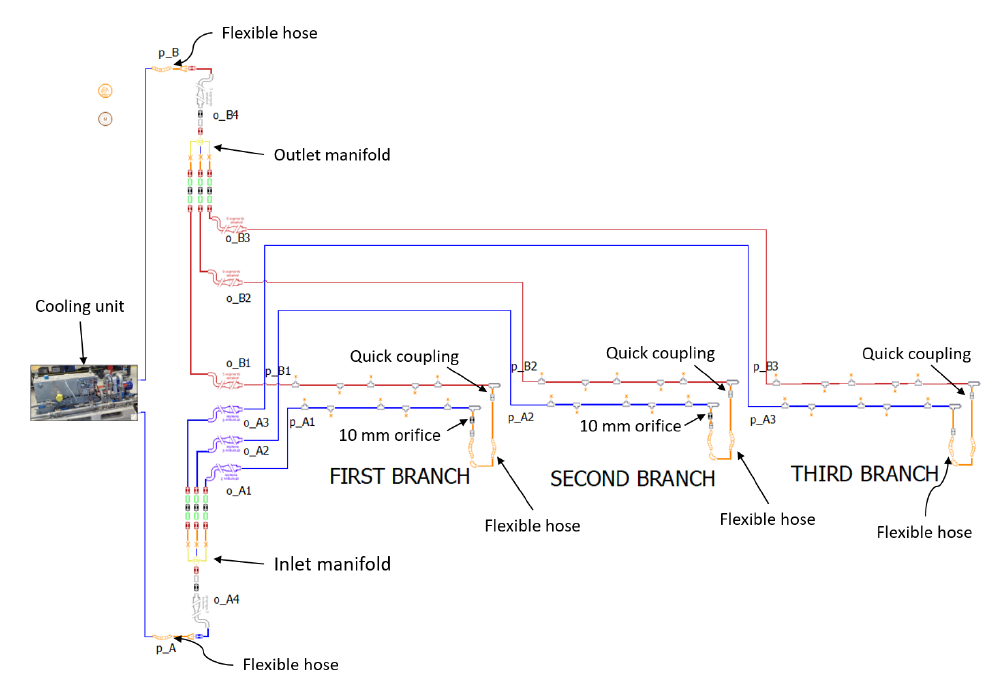
Figure 4. Simcenter AMESim model of the prototype available for testing. The mainly used libraries were Thermal Hydraulic and Thermal Hydraulic